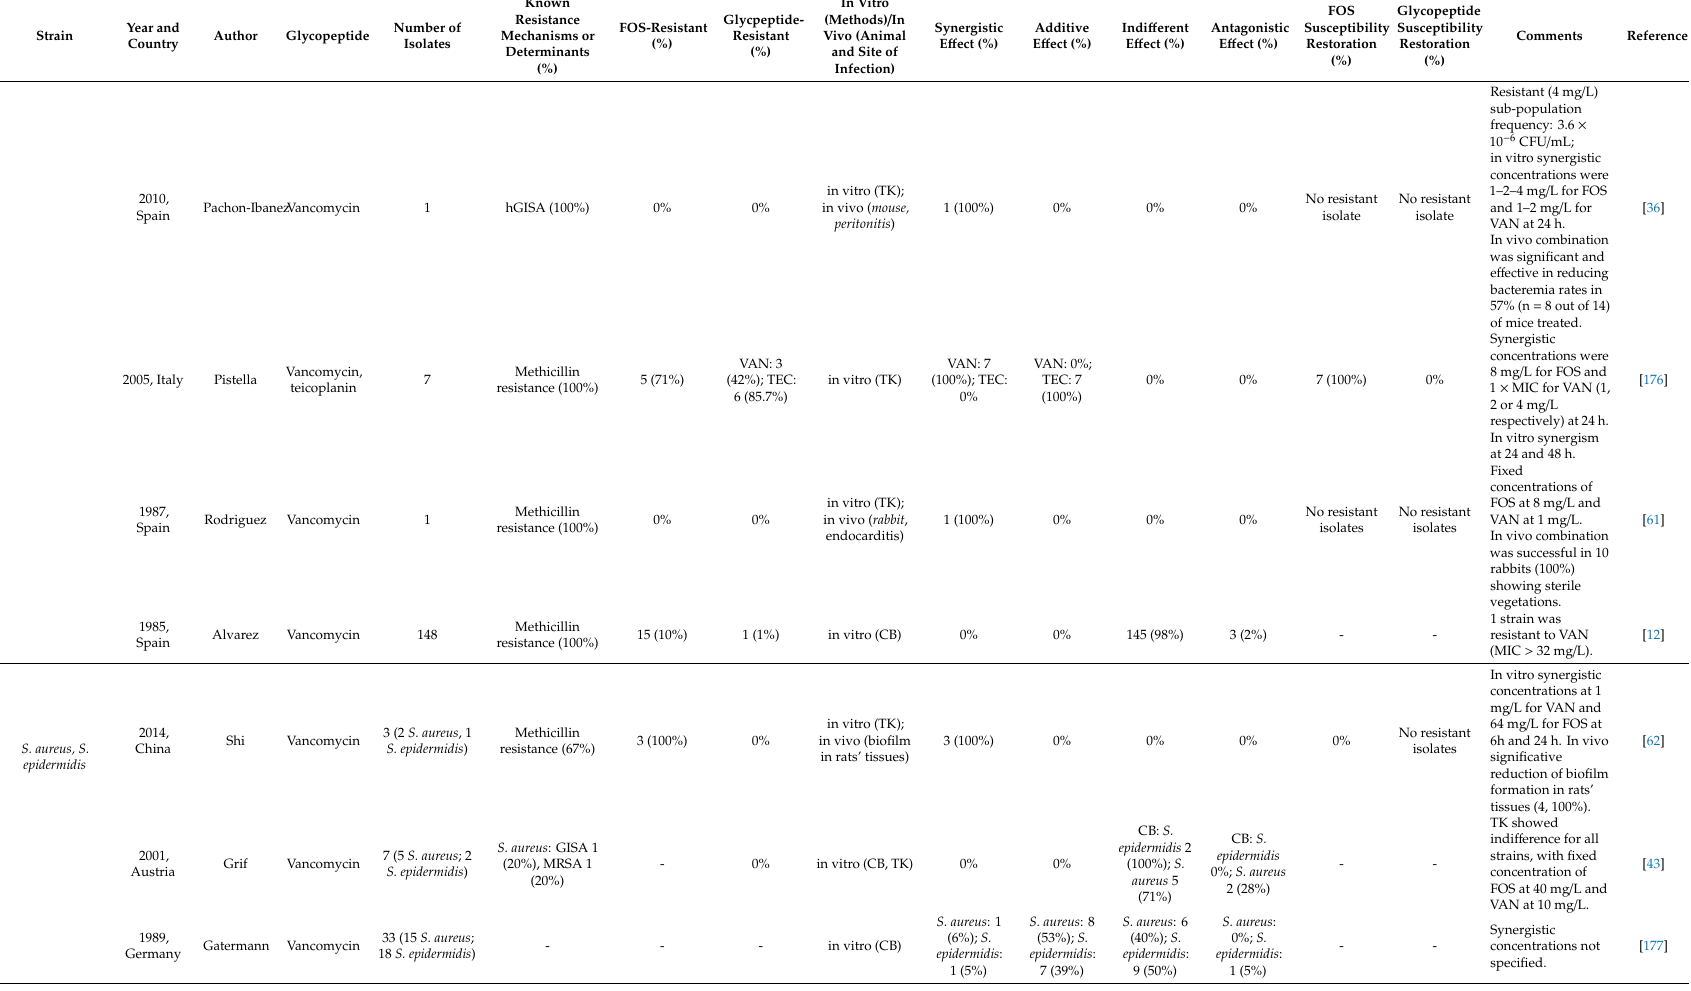
concentrationof FOSat40mg / Land VANat10mg /